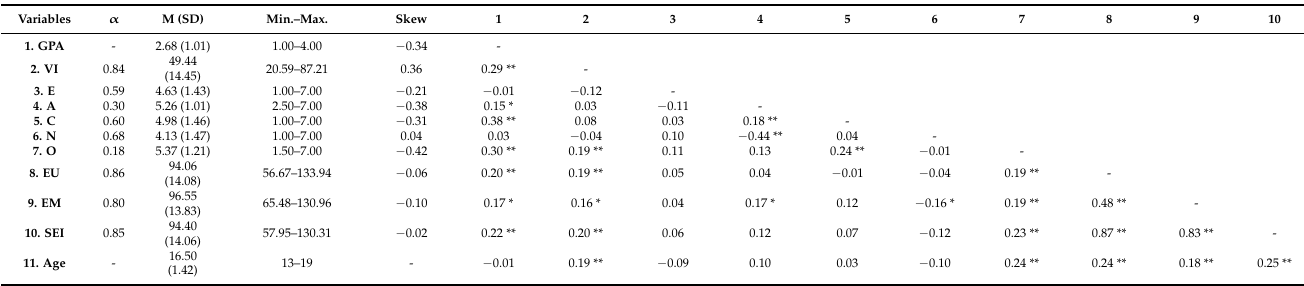
Table 1. Descriptive statistics, internal consistencies, and correlations between